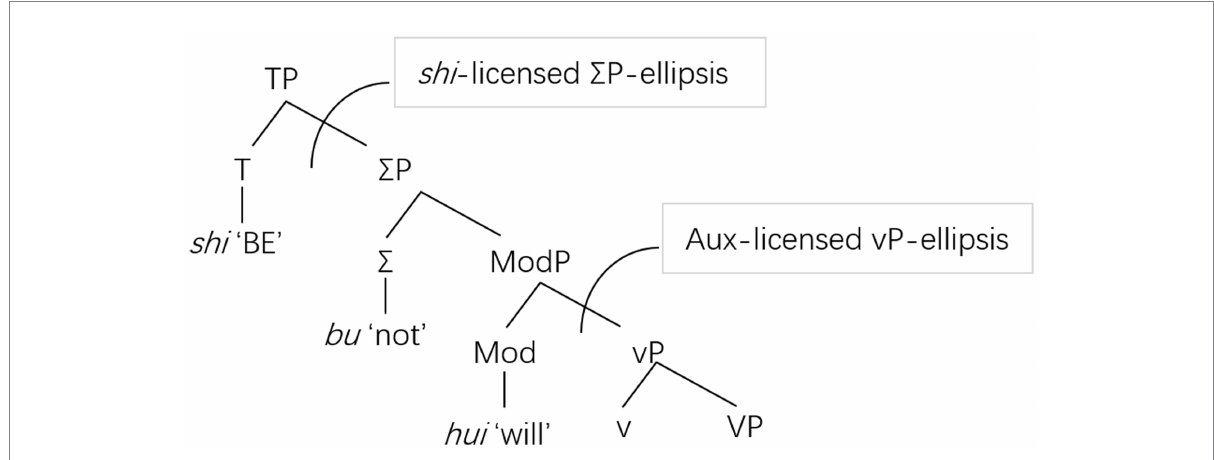
FIGURE 1 Positions of shi “BE” and auxiliaries in the hierarchy. Drawn using data from Soh